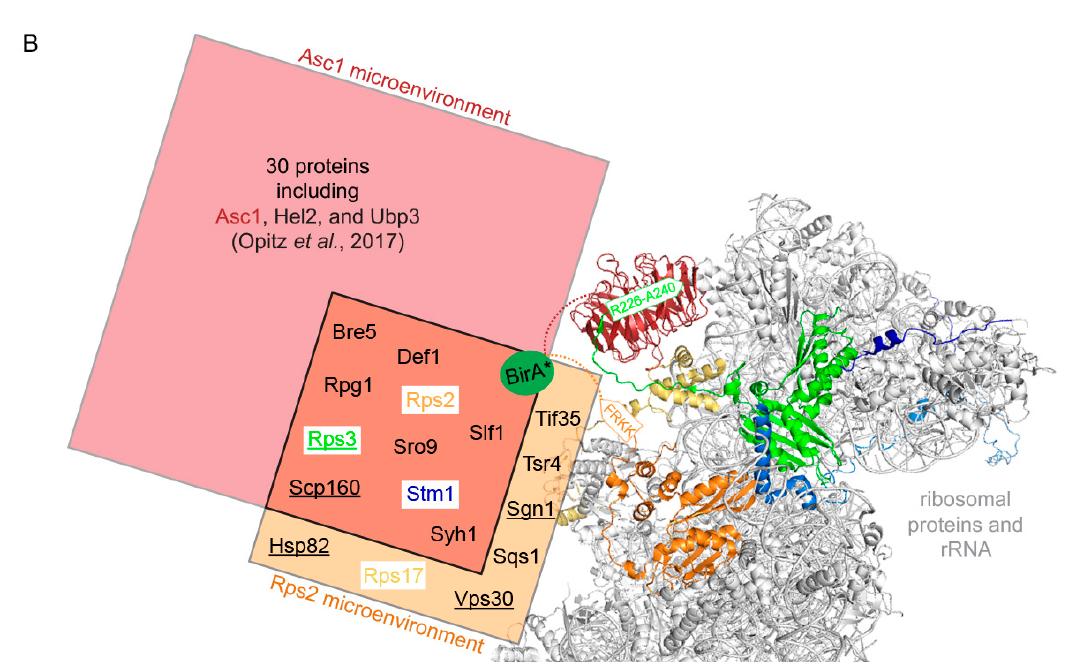
Figure 2. BioID protein capture after Rps2-BirA*-labeling in the presence or absence of Asc1. ( A ) All columns represent the average of MaxQuan t normalized log 2 SILAC ratios of three biological replicates and are provided with the respective standard deviations. Proteins depicted in the graph were enriched with normalized log 2 SILAC ratios for ASC1 RPS2-birA* / birA* greater than or equal to 0.485 (matching a minimum enrichment of approximately 40%) from either ASC1 wild-type cells (gray columns) and / or from asc1 − cells (blue columns). Black dots next to protein names indicate proteins that were exclusively enriched from the asc1 − cells. Orange columns represent the respective fold-changes of the SILAC protein quantification values between ASC1 wild-type and asc1 − cells, indicating the degree of Asc1-dependency in their Rps2 proximal localization. The proteins are ordered from left to right according to increasing absolute di ff erences in enrichment between ASC1 wild-type and asc1 − cells (orange columns). A two-sample t-test on the ASC1 RPS2-birA* / birA* versus asc1 − RPS2-birA* / birA* log 2 SILAC ratios was performed, and significant changes were indicated with one or two asterisks ( p -value threshold 0.05 and 0.01, respectively). A green rectangle next to the protein name indicates the identification of a biotinylated peptide for the respective protein. Although the data for Ubp3 did not pass the described filtering, they are provided for the discussion (see main text). The graph is based on the data in Table S1. ( B ) Comparison of the Asc1 and Rps2 microenvironments captured with BioID: The hr40S is illustrated as in Figure 1A. The biotin ligase BirA* (green sphere) was fused via a linker sequence to the C-termini of either Asc1 or Rps2 (indicated with dashed lines in red and orange, respectively). The proteinaceous microenvironment of Asc1 [18] is indicated with a red rectangle and that of Rps2 with an orange one. Proteins identified in the neighborhood of both proteins are listed in the overlap of both rectangles and are supposed to belong to a common microenvironment. Proteins only identified in the absence of Asc1 within the Rps2 microenvironment are underlined. Proximity between Asc1 or Rps2 to their neighboring proteins might also take place apart from a mature 40S ribosomal subunit. The PyMOL Molecular Graphics System software was used to generate the figure from crystal structure data of the S. cerevisiae 80S ribosome (PDB entry: 4V88) [15].